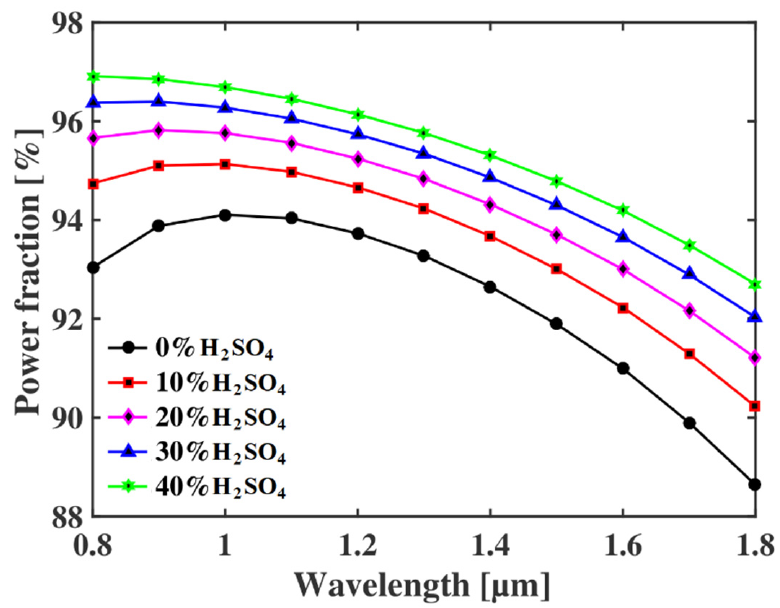
Figure 3. Power fraction of the proposed sulfuric acid detector at different operating wavelengths.